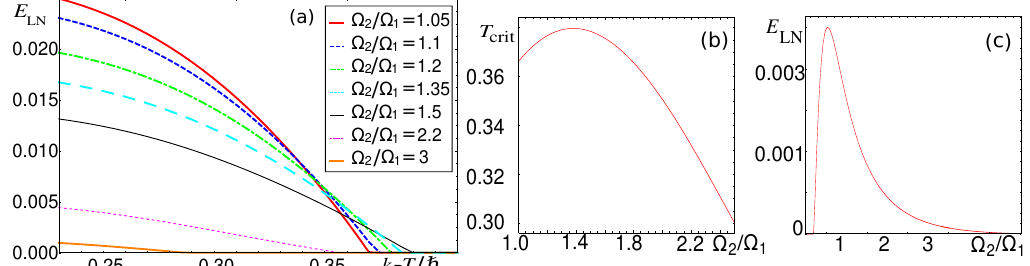
Figure 7: Trapping frequency dependence of the entanglement between the two kinds of impurities. In (a) we study entanglement as a function of T for various ratios between / Ω the trap frequencies of each kind of impurity. For each Ω , at certain T , the 2 1 crit / Ω entanglement vanishes. The dependence of T as function of Ω is shown in (b). crit 2 1 (c) illustrates that the entanglement at fixed T has a maximum value for certain value / Ω = 500 ( µ m ) − 1 and g = 9.75 · 10 − 39 J · m were used in of Ω . The parameters n 2 1 0 B this case. In all of the graphs, we are considering impurities of potassium K in a bath = 600 π Hz , of particles of Rubidium Rb. The parameters used in these plots are: Ω 1 η = 0.325, η = 0.295, n = 90 ( µ m ) − 1 , T = 4.35 nK , g = 2.36 · 10 − 38 J · m and 1 2 0 B / a = R 12 HO